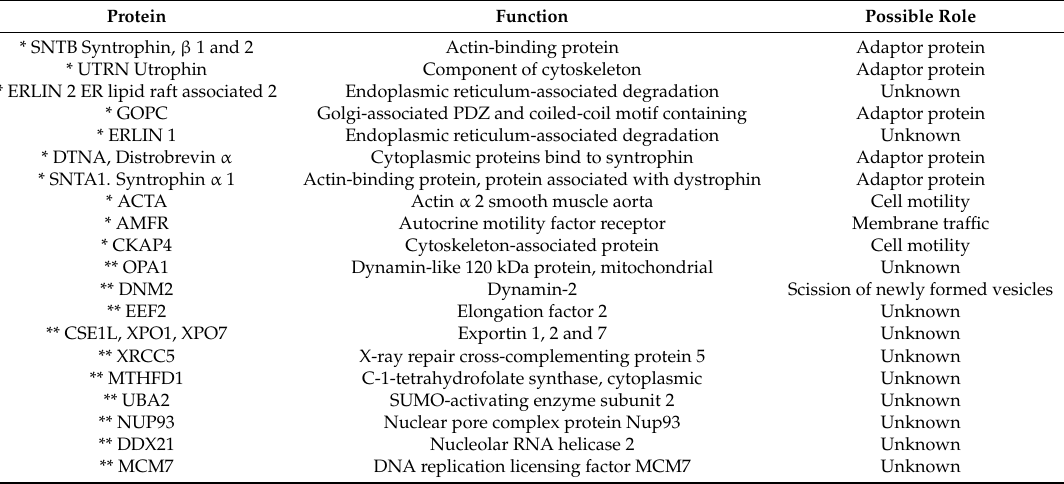
Table 4. Protein detected MS of immuno-purified α 1D -adrenoceptors. * Data from [125]; ** our data. Protein Function Possible